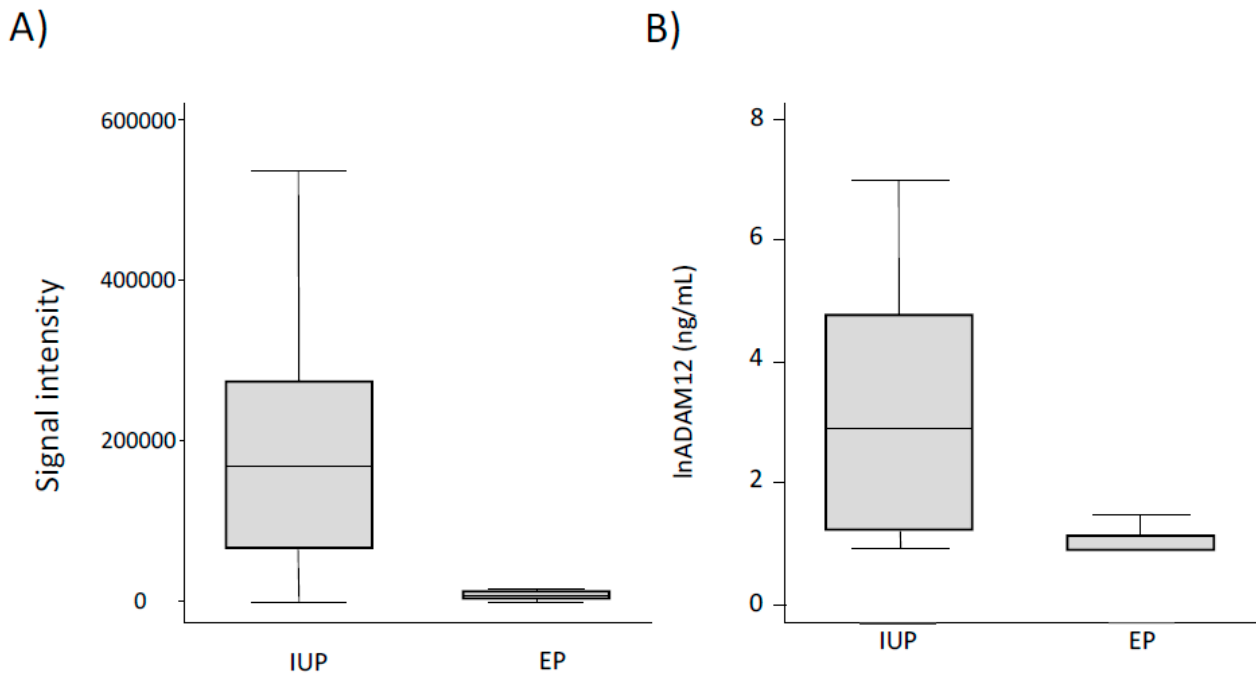
Figure 5. Statistical analysis of the intensity of ADAM12 peptides observed in a quantitative proteomics analyses using ( A ) multiple reaction monitoring mass spectrometry (MRM-MS) and ( B ) immunoassay comparing serum samples obtained from woman with ectopic pregnancies (EP) and normal intrauterine pregnancies (IUP). The MRM-MS data were compiled from the analysis of 9 EP and 9 IUP serum samples, while the immunoassay data was compiled using 99 EP and 100 IUP samples. Adapted from [51].